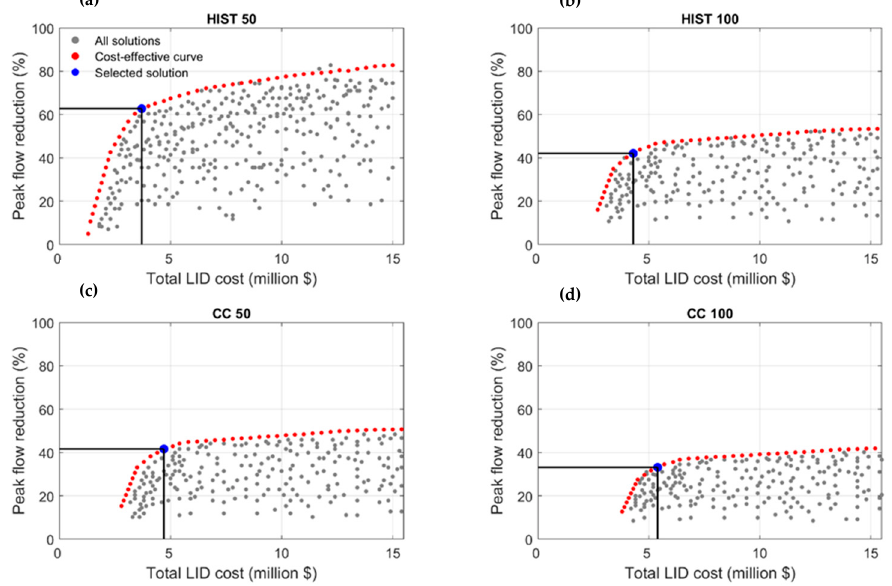
Figure 7. The trade-off for peak flow reduction and cost of LIDs under past- (HIST 50, HIST 100) and future-scenario (CC 50, CC 100) storms.